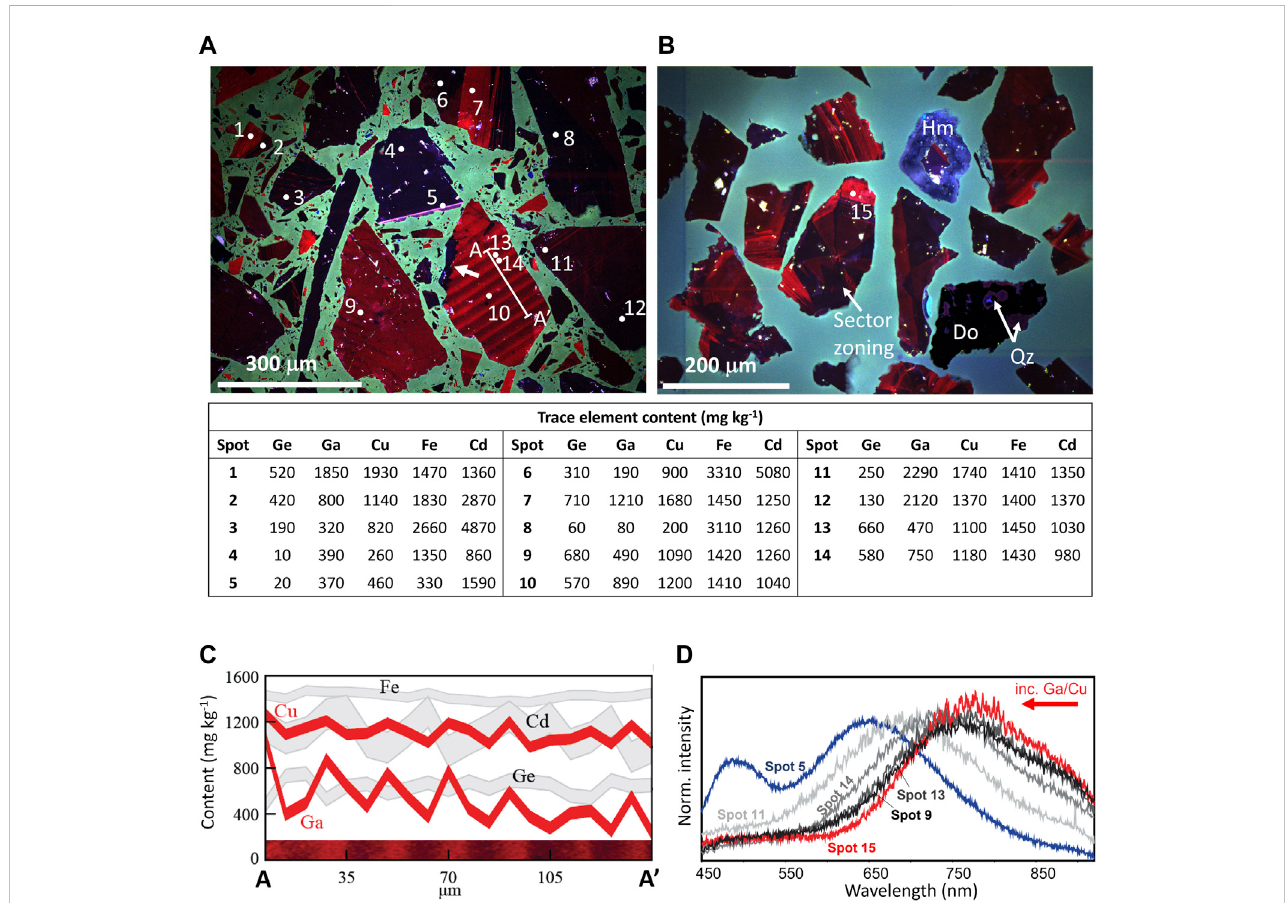
FIGURE 5 Cathodoluminescence variability in sphalerite. All large grains in images are sphalerite, unless otherwise indicated, and the mounting epoxy luminesces green and blue. (A) RGB- fi ltered CL image of a Central Tennessee sphalerite concentrate (Conc G), including microprobe analyses for selected trace elements( spots1 – 14 ).GrainsarehighlyvariableinCLresponseandchemistry,butdarkgrainsareuniversallyhigher inFethanredgrains,whichtypicallyhave higher Cu, Ge, and Ga content. Traverse A-A ′ is indicated with a white line and is orthogonal to oscillatory zoning, whereas a white arrow indicates an example of zoning truncation, indicative of multiple generations of sphalerite. (B) RGB- fi ltered CL image of a sphalerite concentrate from Tar Creek (Mahutska). (C) MicroprobetraverseofoscillatoryzonedsphaleriteindicatedinFigure5Atraverse(AtoA ′ ).Inthistraverse, thelinewidthrepresents1standard deviation. Red luminescence correlated directly with Cu and Ga, and generally inversely with Cd. The relationship with Ge and Fe were less clear. (D) CL spectroscopic response of spot locations indicated in Figures 5A,B. These preliminary data suggest a blue shift with increasing Ga/Cu. Minerals: Hm = hemimorphite, Do = Dolomite, Qz =